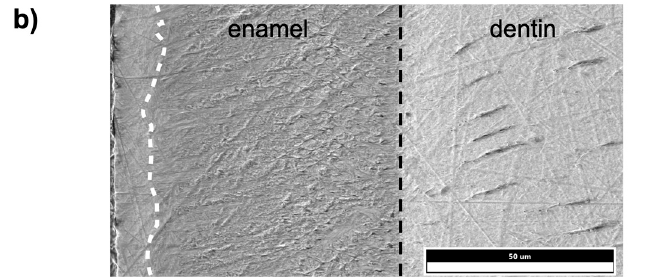
Figure 8. ( a ) EDX line scan from the tooth surface (left edge, enamel) into the dentin on a murine incisor in the post-eruptive area. The black dashed line indicates the enamel-dentin junction. The blue graph shows the counts in iron at the respective positions of the measuring line shown in green. ( b ) SEM image of a specimen of a murine incisor. The superficial 10 µm of enamel (left margin, separated by a white dashed line) shows a brighter texture than below the surface, and thus, a dif-